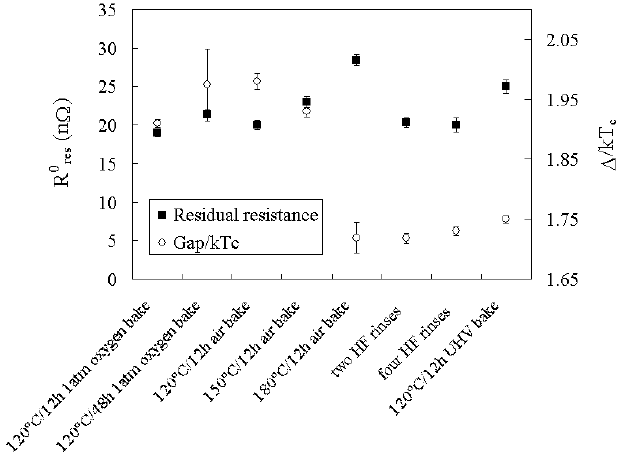
FIG. 9. Q vs B measured at 2.0 K after etching with BCP p 0